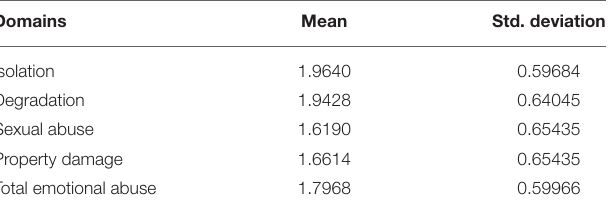
TABLE 2 | Descriptive statistics of the emotional abuse domains. Domains Mean Std. deviation